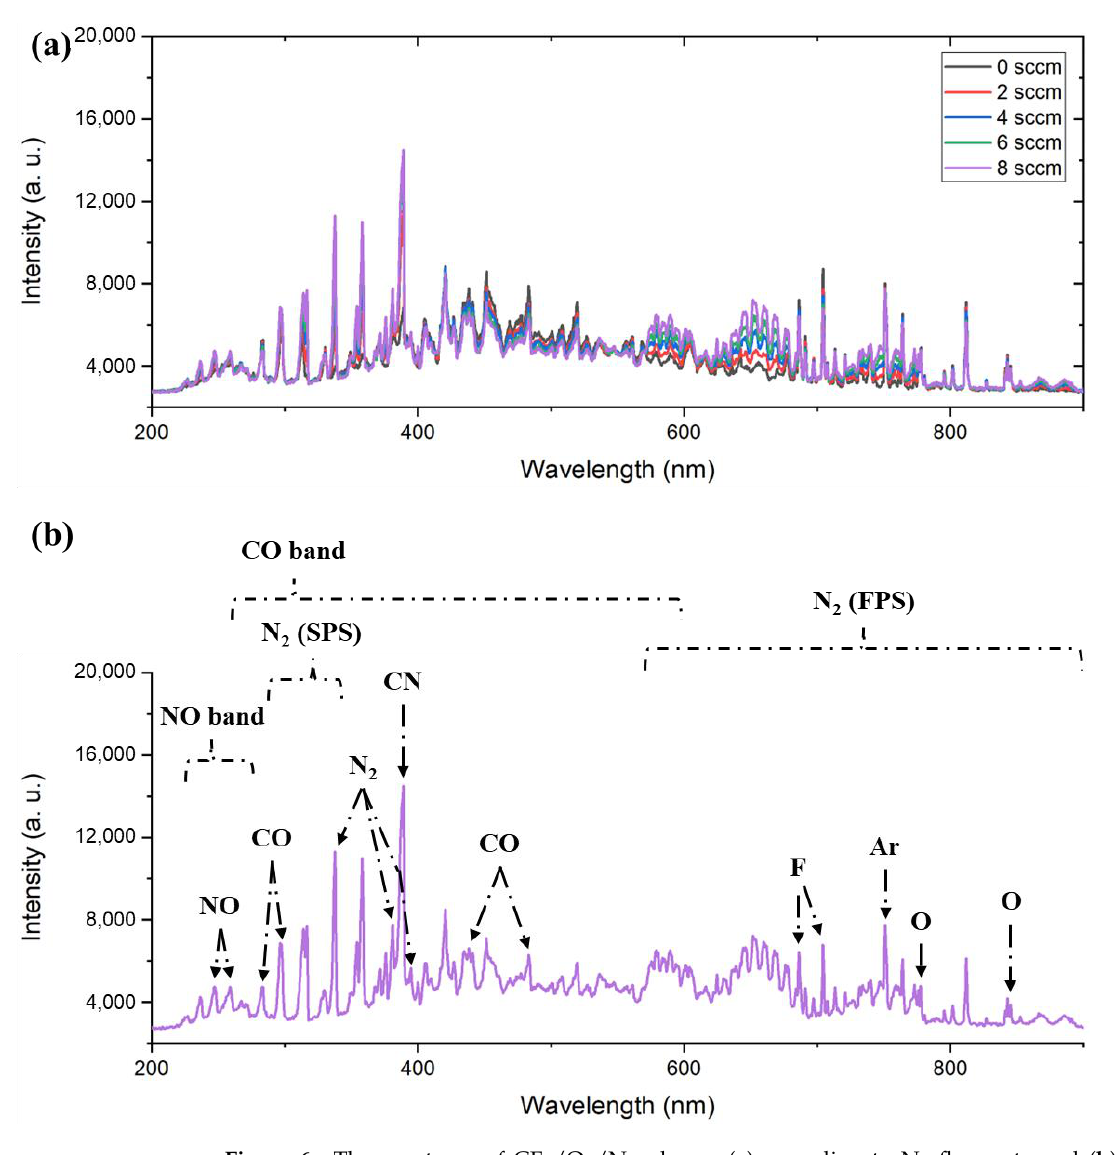
Figure 6. The spectrum of CF 4 /O 2 /N 2 plasma ( a ) according to N 2 flow rate and ( b ) selected wavelength of each species in the N 2 and 8-sccm cases. We selected the wavelengths of atoms and molecules. Representative peaks were used in the case of molecules as the OES spectrum of molecules has band-shaped emission spectra.